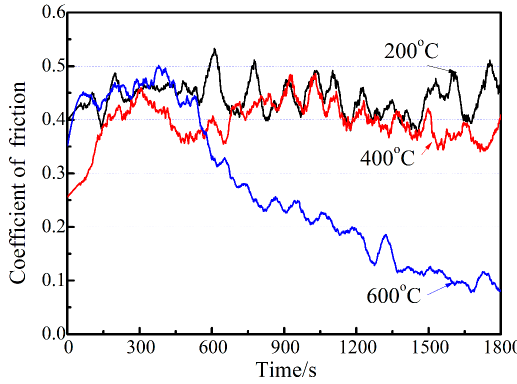
Figure 2. CoF of steel ball/a-Si:H films under different temperatures.